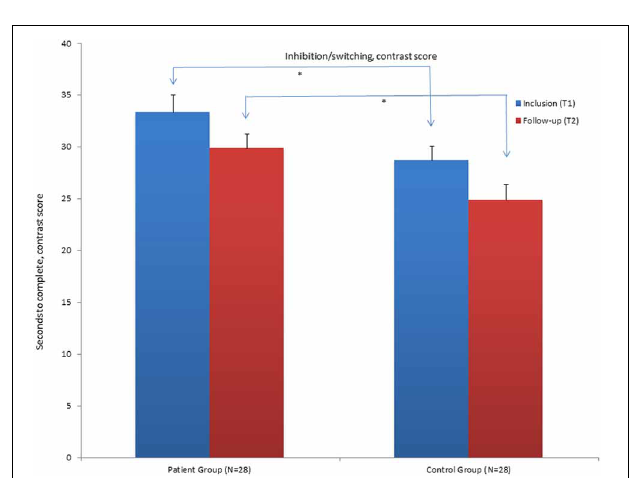
FIGURE 2 | Mean contrast scores for the Inhibition/switching condition of the Color Word Interference Test (CWIT) for the patient group and control group at inclusion (T1) and at follow-up assessment (T2). ∗ Significant differences between the groups. Graphs represent mean Standard Error (SE).